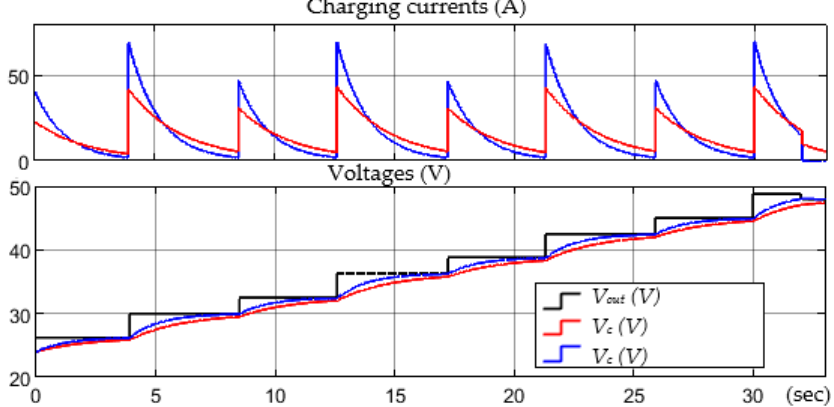
Figure 43. Simulation results of the cases with considering (red) and without considering the SC circuit board trace resistance.